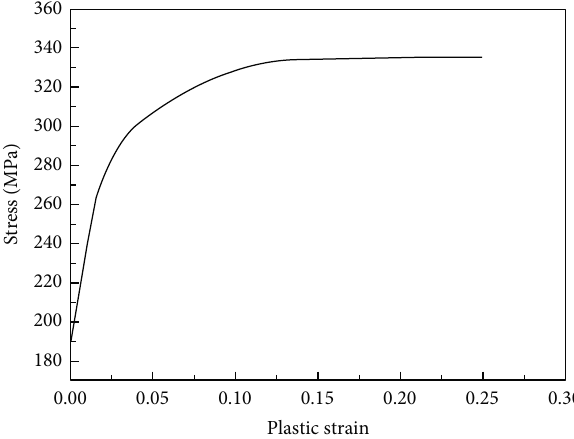
Figure 7: A thickness model (a) and the corresponding FE model (b).